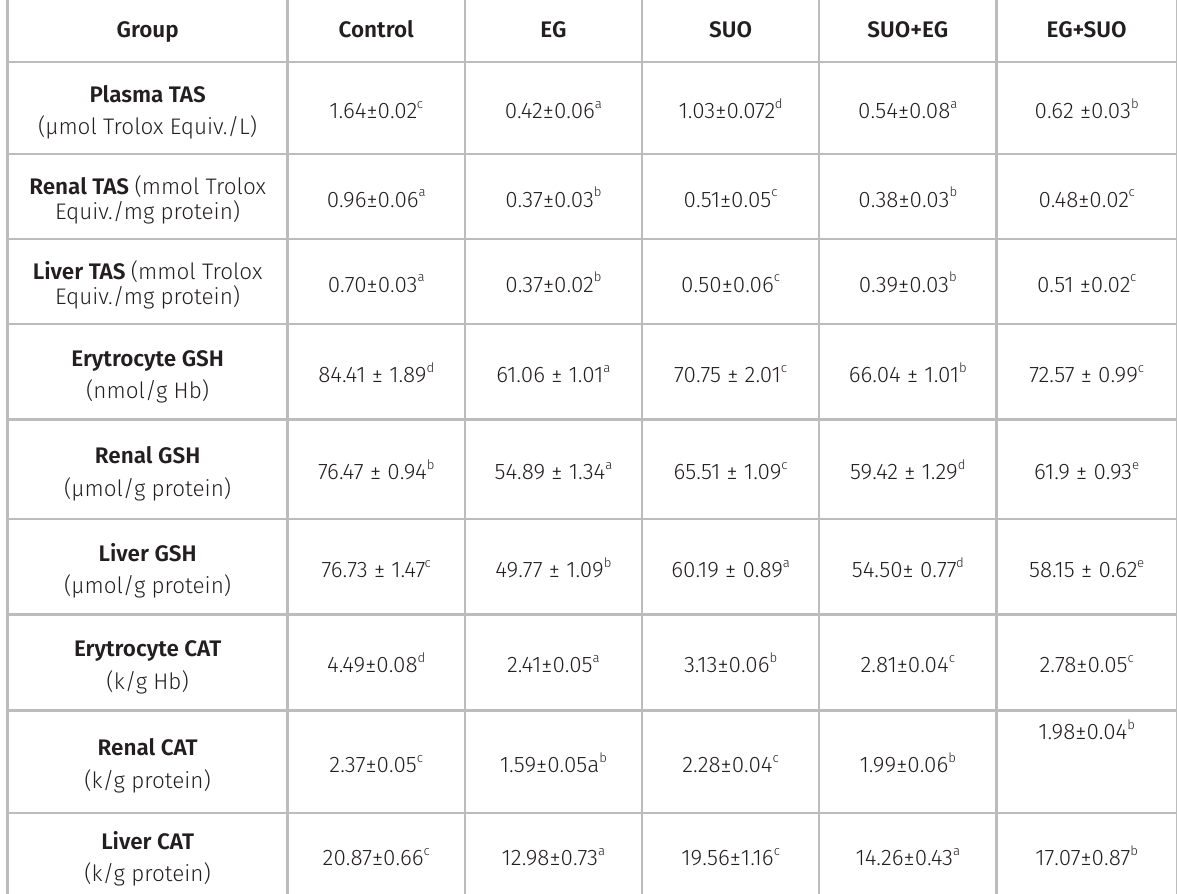
Table II. Erythrocyte, plasma, kidney and liver tissue antioxidative marker (TAS, GSH, CAT) levels. Group Control EG SUO SUO+EG EG+SUO Plasma TAS (µmol Trolox Equiv./L) Renal TAS (mmol Trolox Equiv./mg protein) Liver TAS (mmol Trolox Equiv./mg